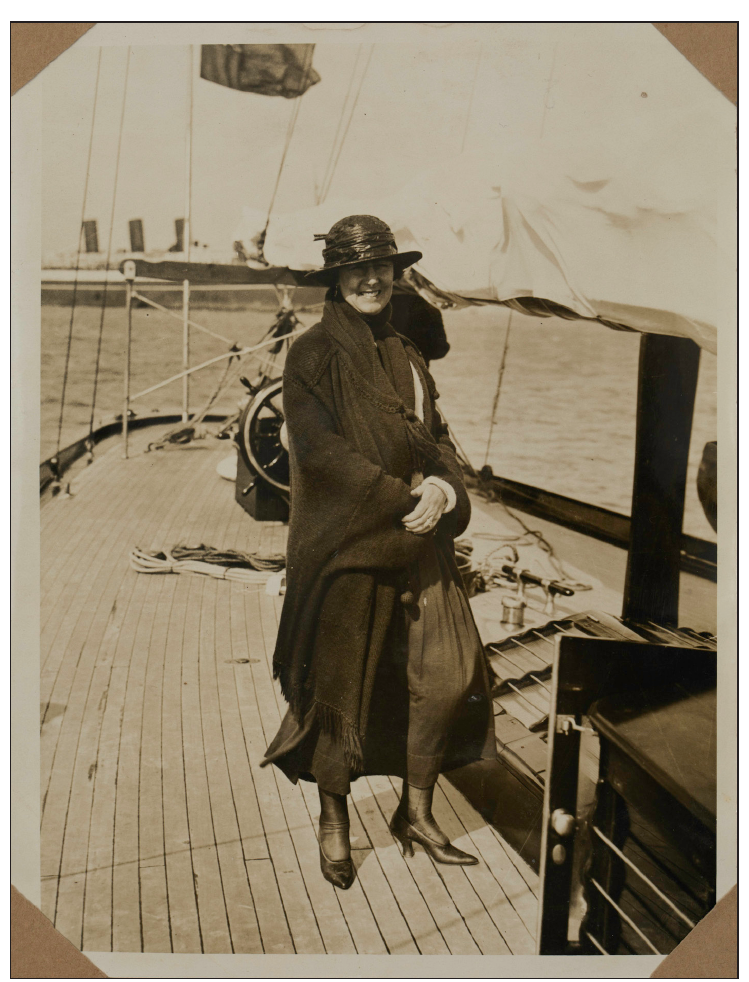
Fig. 1 : Elizabeth Workman on board Nyria , c . 1920. Photo by kind permission of the Janson